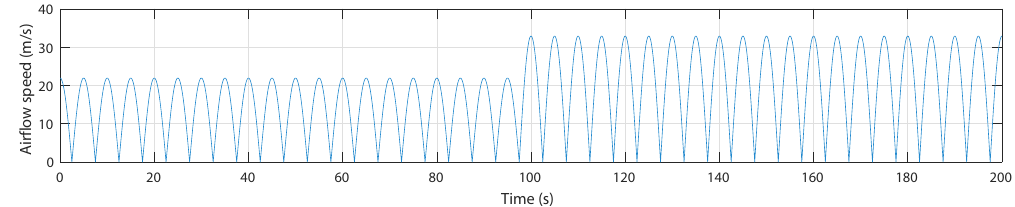
Figure 20. Airflow speed from incoming wave